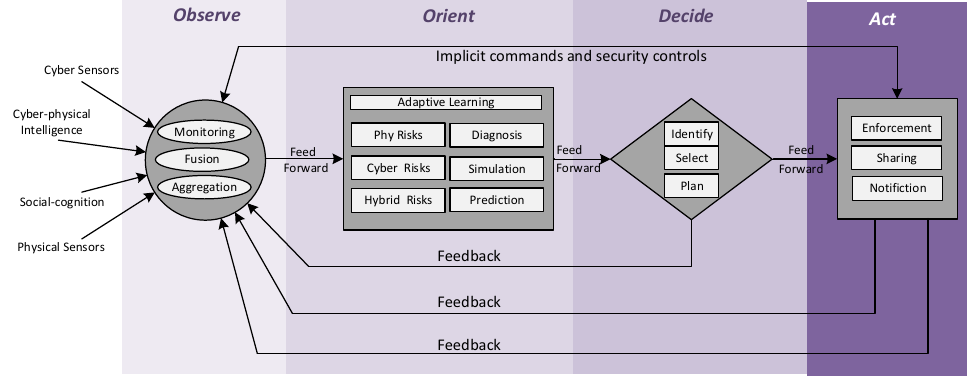
Figure 2. Example of OODA loop for assisting cyber-physical